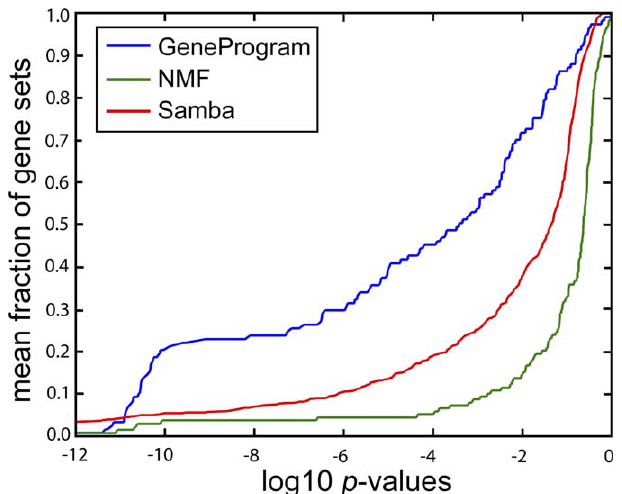
Figure 5. GeneProgram Outperformed Two Popular Biclustering Methods, an NMF Implementation and Samba, in Terms of Gene Set Consistency between Two Large Compendia of Mammalian Tissue Gene Expression Data Because the two data compendia used different microarray platforms and sources for tissues, similarities in discovered gene sets between compendia were likely to be biologically relevant. For each algorithm, we used gene sets discovered from one data compendium to compute the significance of the overlap ( p -values) with sets produced using the second compendium. We then inverted the analysis and averaged the results to produce the correspondence plots shown. The plots depict log p -values on the horizontal axis and the fraction of gene sets with p - values below a given value on the vertical axis (see the Methods section for details). The larger fraction of gene sets at most p -values suggests that GeneProgram generally produces the most consistent results between the data compendia.